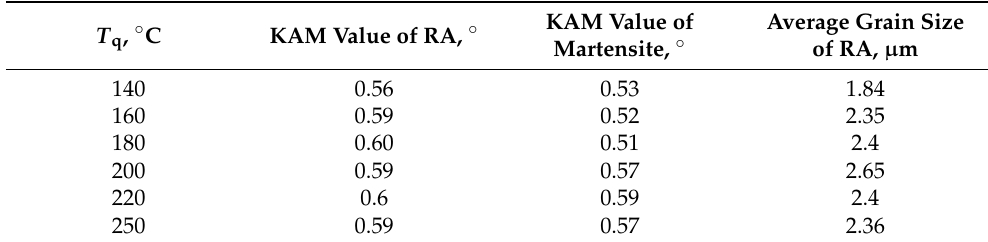
Table 2. Effect of quenching temperature on the KAM value of RA/martensite and the average size of RA.